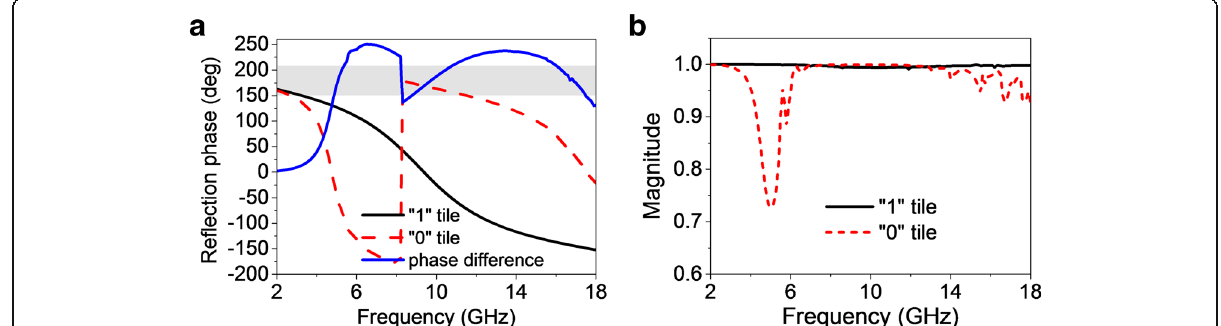
Fig. 5 Reflection characteristics of the anisotropic element with floquet port excitation. a Reflection phases and phase difference between “ 0 ” and “ 1 ” elements. b Reflection magnitudes